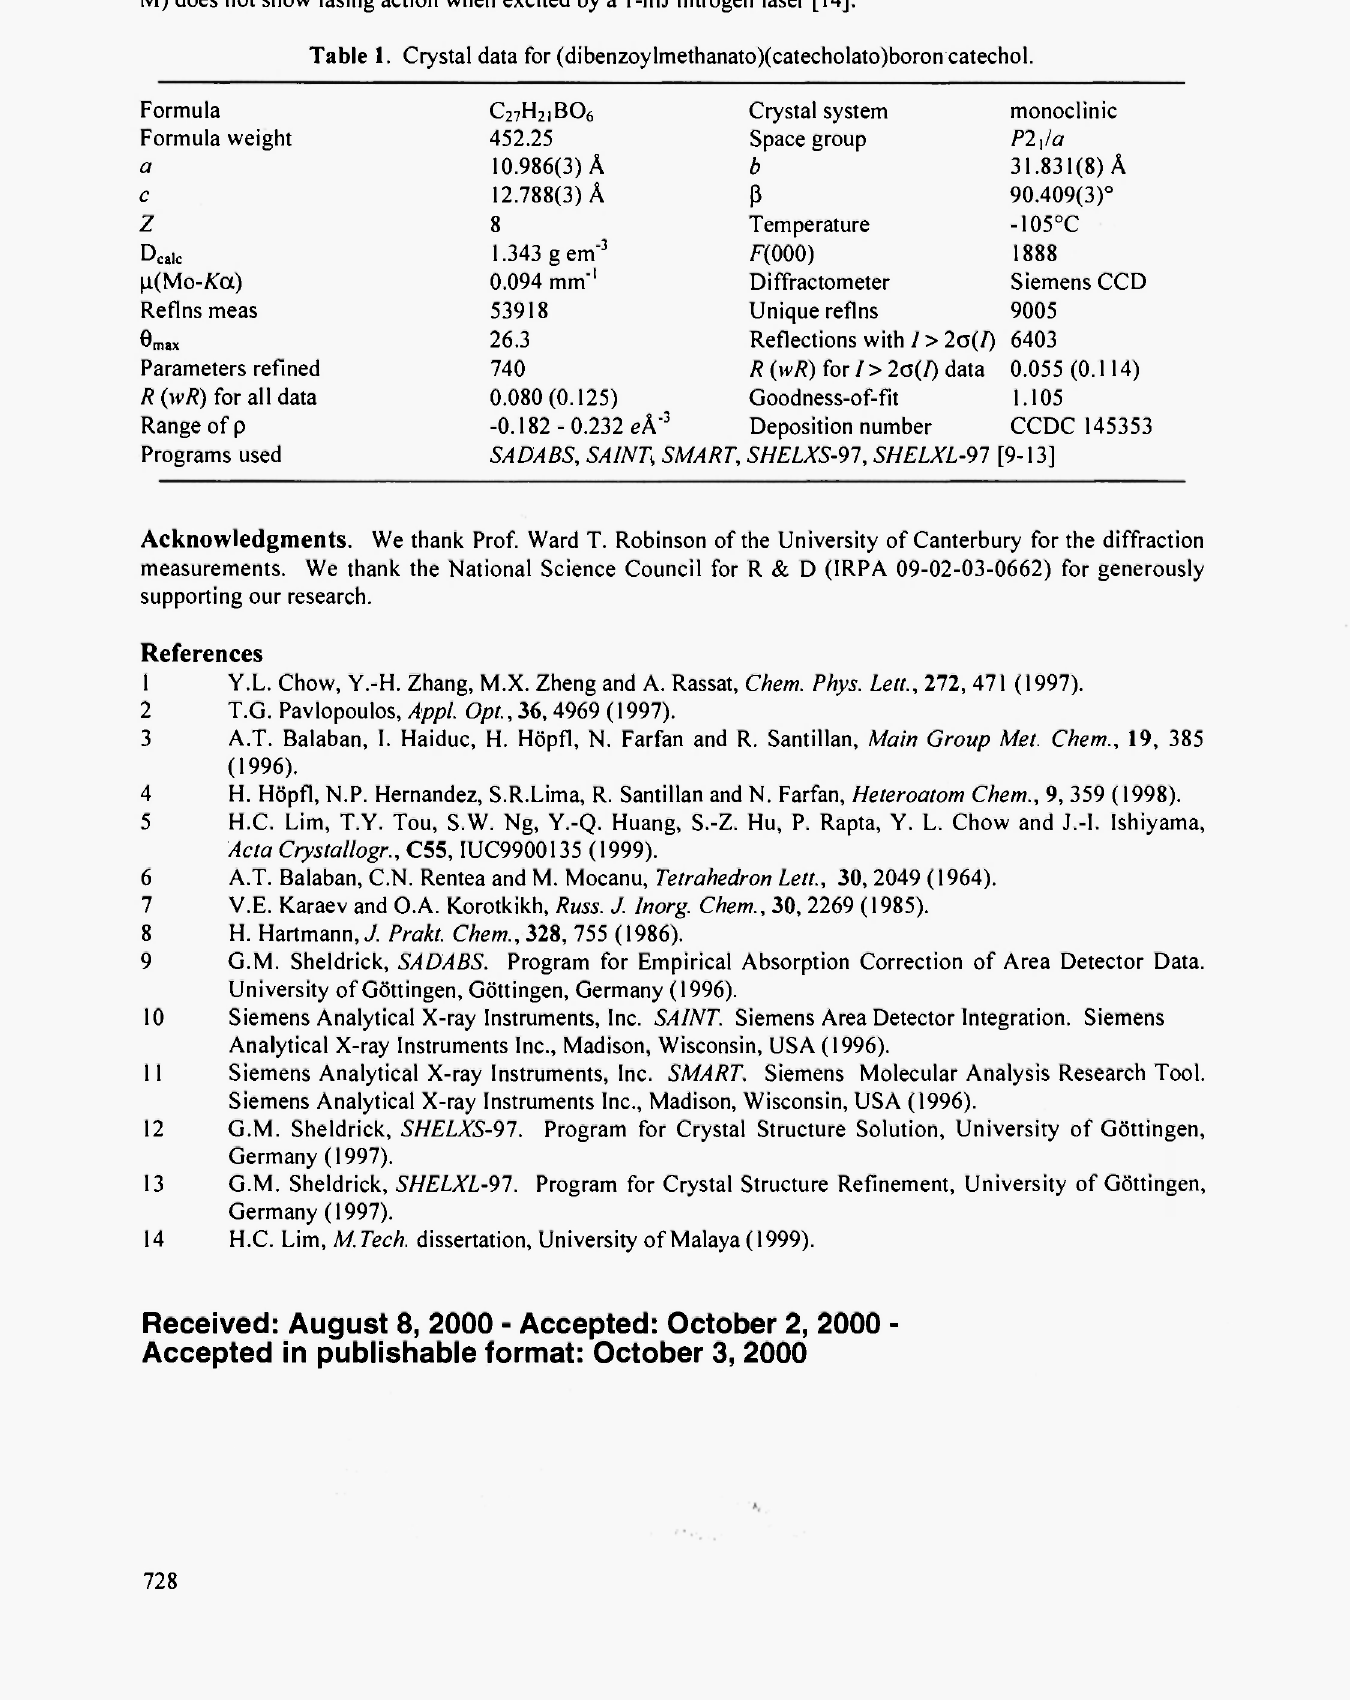
Table 1. Crystal data for (dibenzoylmethanato)(catecholato)boron